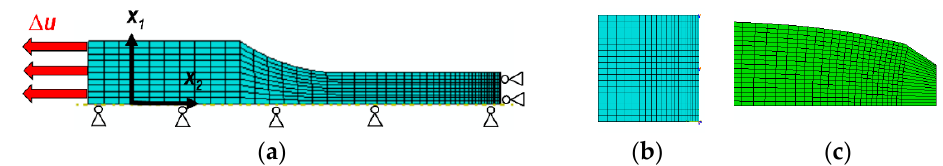
Figure 10. Numerical model of the tensile specimen ( a ); undeformed mesh fragment near blocked plane ( b ); deformed mesh fragment near blocked plane ( c ).